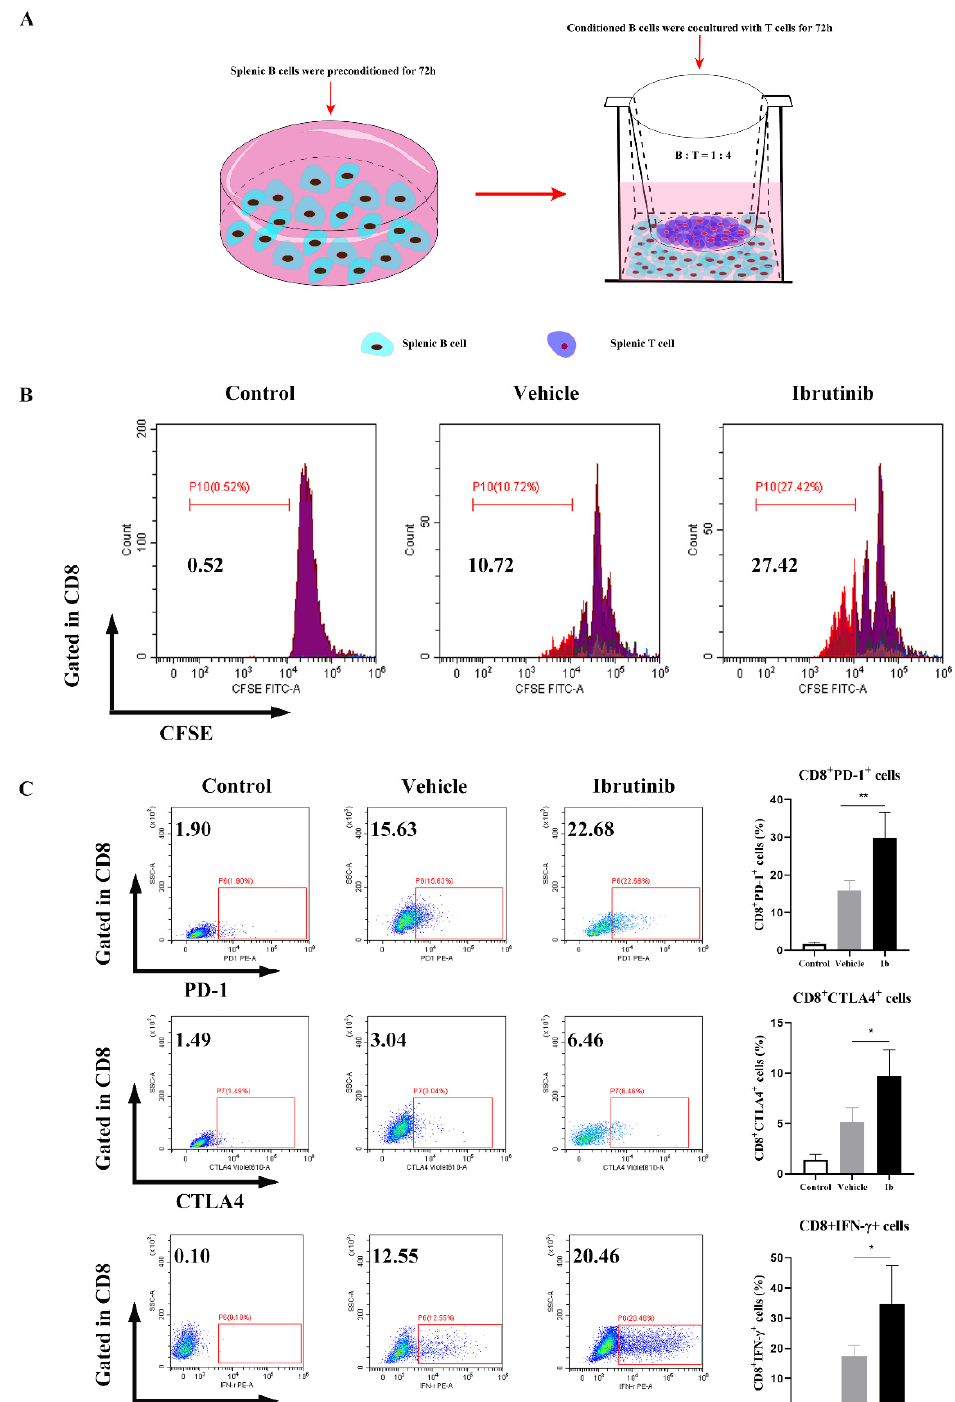
Figure 6. Ibrutinib-treated B cells promote the proliferation of CD8 + T cells with elevated PD-1, CTLA4, and IFN- γ expression in vitro. ( A ) Illustration of the culture system. The conditioned B cells were co-cultured with T cells stimulated with anti-CD3 and anti-CD28 antibodies for 72 h. ( B ) Representative flow cytometry plots showing CD8 + T cell proliferation by CFSE staining after co-culturing with conditioned B cells for 72 h. ( C ) Representative flow cytometry plots of PD-1, CTLA4, and IFN- γ expression in CD8 + T cells after co − culturing with conditioned B cells for 72 h. A p value less than 0.05 was considered statistically significant. *, p < 0.05; **, p < 0.01.